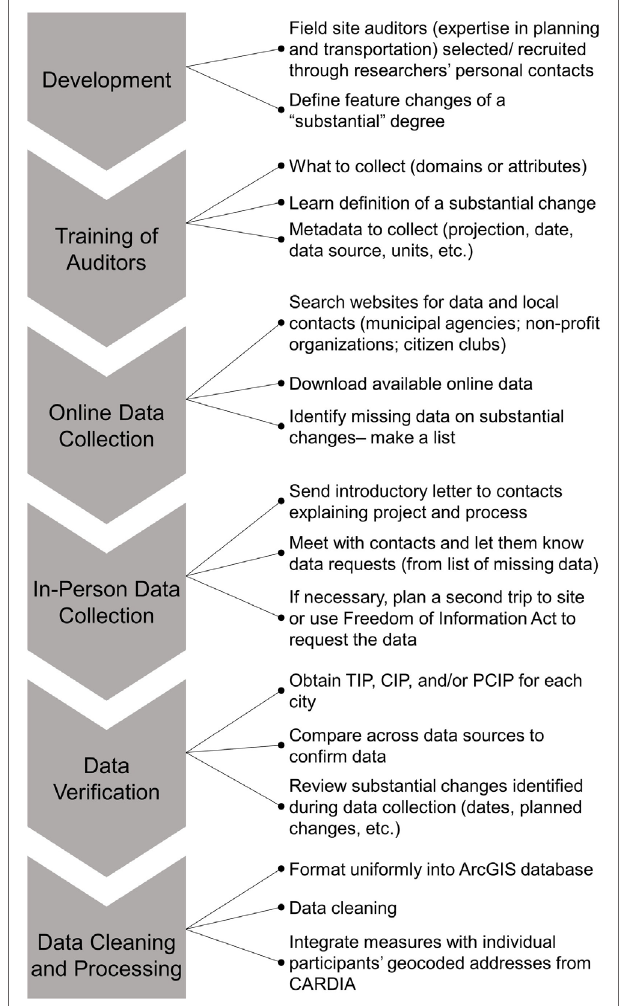
FIGURe 1 | Flow chart of the overall process used for retrospective field audits